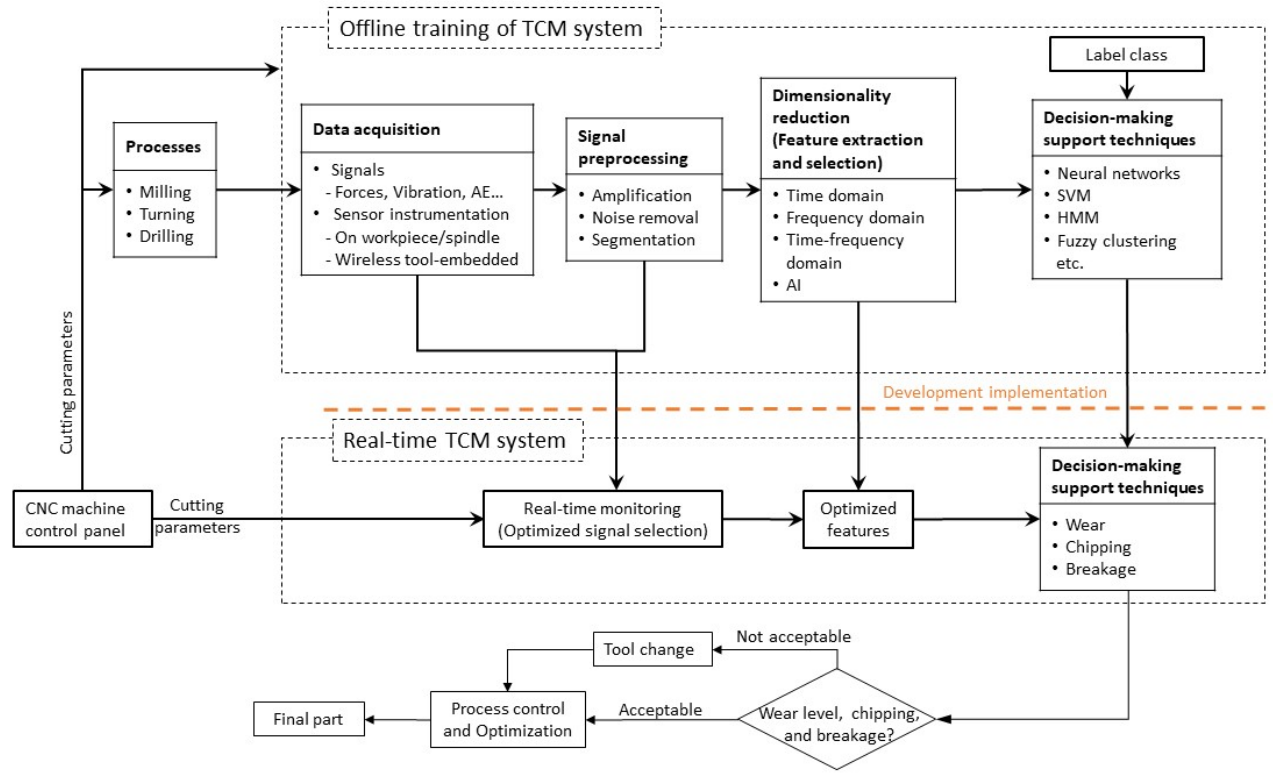
Figure 1. Tool condition monitoring in machining processes.